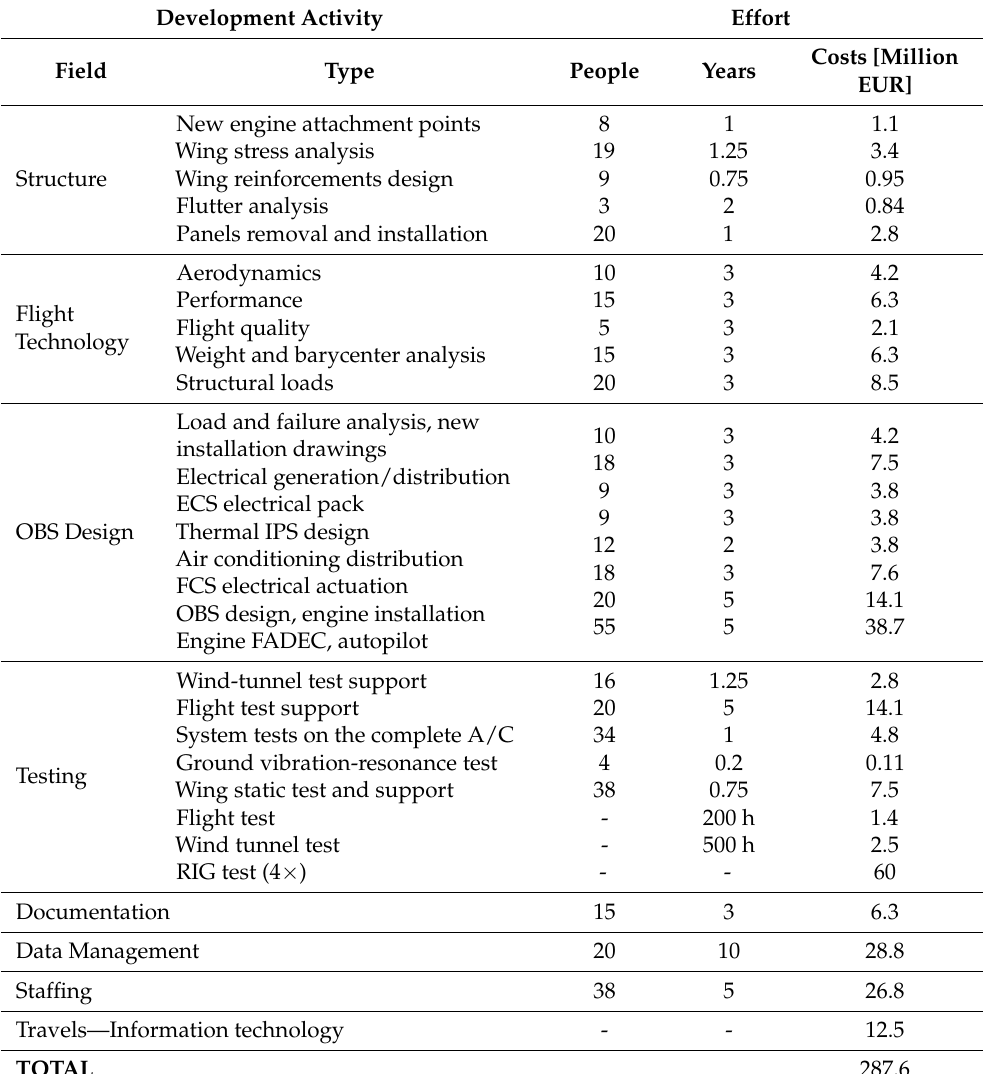
Table 5. List of the development activities and their related efforts (in terms of the number of people, time and costs) required to perform the aircraft